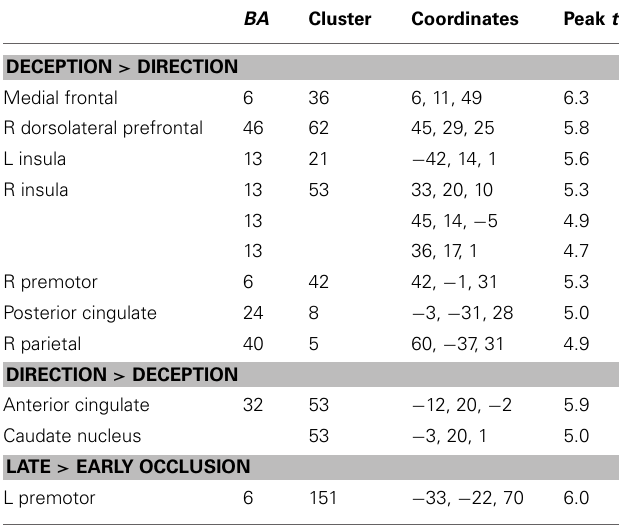
Table 6 | Peak activations at p < 0.05 FWE corrected.